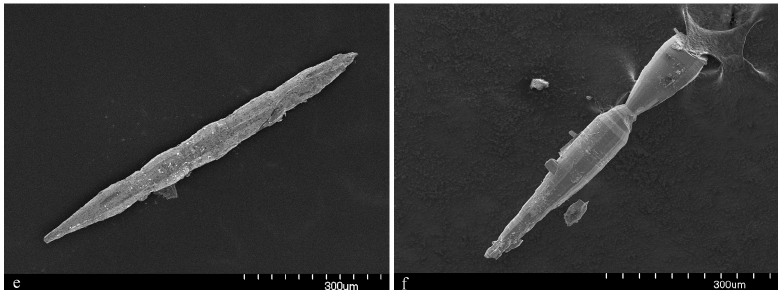
Figure 4. Scanning electron microscope (SEM) images of samples taken from the holotype specimen. ( a ) Cluster of merelaniite whiskers with one notably larger cylinder, associated with graphite. (Sample 3666i-190i.); ( b ) Section of a merelaniite-graphite cluster showing well-formed graphite crystals (Sample 3666i-190h.); ( c , d ) Merelaniite whiskers showing partially un-wound layers. (Sample 3666-196a.); ( e , f ) Individual whiskers showing conical ends and undulating diameters (Samples 3666i 190d and 3666 196c). Images taken using a Hitachi S-4700 field-emission SEM (Hitachi, Tokyo, Japan).